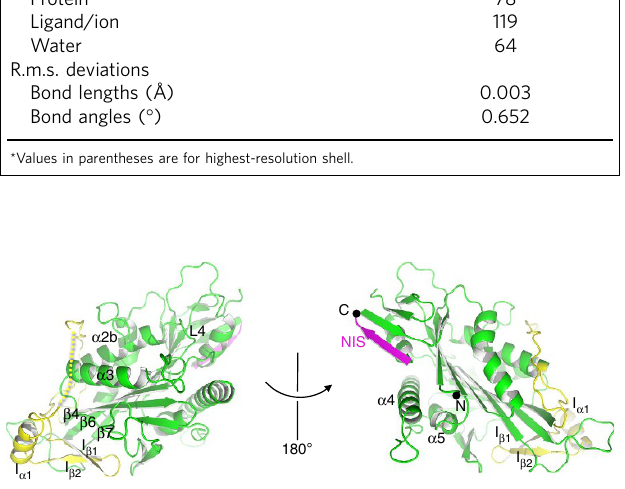
Figure 1 | Structure of Zen4 in the nucleotide-free state. Two different views of the overall structure of kinesin Zen4. The unique insertion sequence, yellow; the NIS, magenta. The N- and C-termini of Zen4 are labelled with black